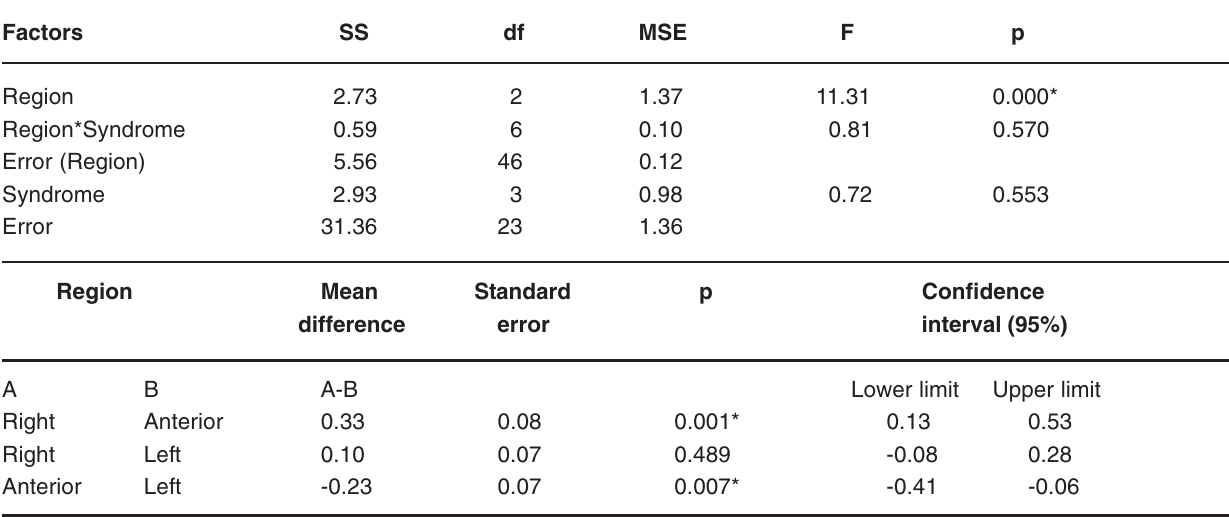
TABLE 3- Comparison of attachment level according to region and syndrome (ANOVA)